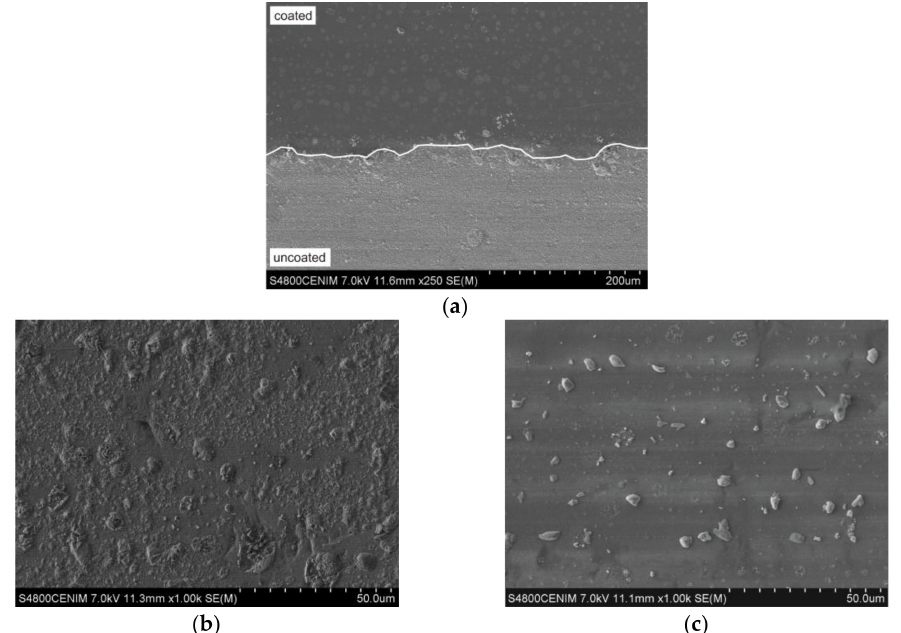
Figure 8. ( a ) FESEM image of a bronze substrate in the coated/uncoated interface (La(Ac) 3 doped coating) after the weathering test under organic acids atmosphere; ( b ) Detail of the uncoated area; ( c ) Detail of the coated